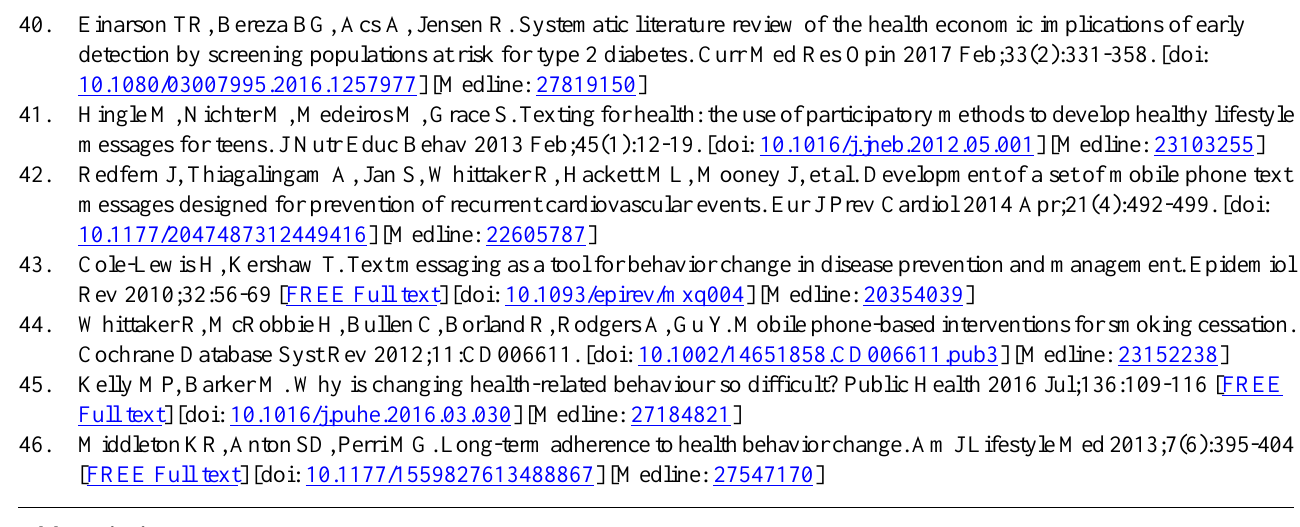
Abbreviations CDC: Centers for Disease Control and Prevention REDCap: Research Electronic Data Capture T2DM: type 2 diabetes